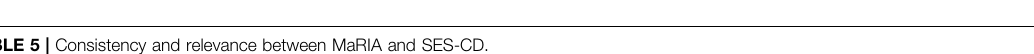
TABLE 5 | Consistency and relevance between MaRIA and